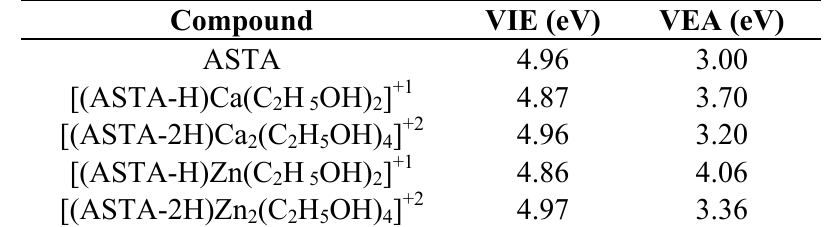
Table 4. Vertical Ionization Energy (VIE) and Vertical Electron Affinity (VEA) in ethanol, calculated with the LC-wPBE